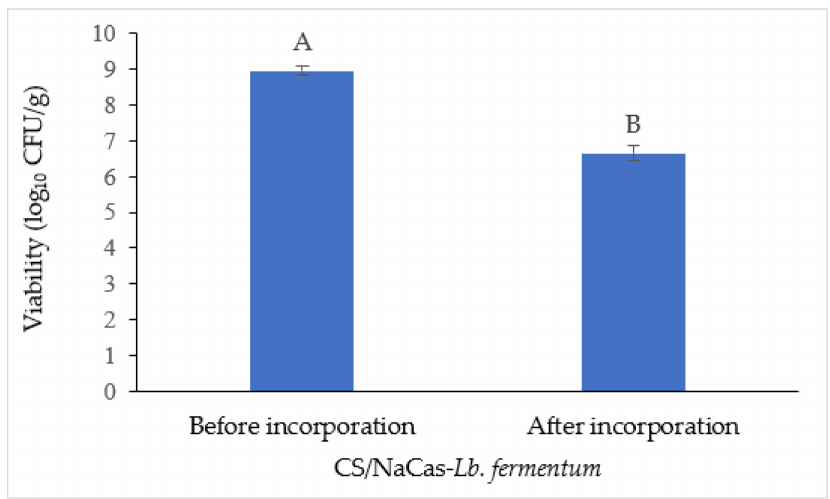
Figure 2. Viability of Lb. fermentum after incorporation into chitosan (CS)/sodium caseinate (NaCas) composite edible films. The results are expressed as mean ± standard deviation ( n = 3). Different letters ( A , B ) mean that there were significant differences via a paired t -test.